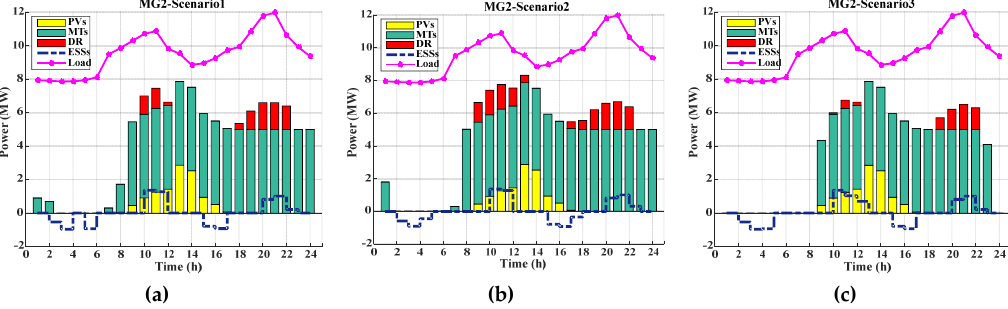
Figure 7. Hourly operation scheduling of the MTs, DR programs and ESSs in MG2 for CS1: ( a ) scenario 1; ( b ) scenario 2; ( c ) scenario 3. Energies 2019 , 12 , 1766